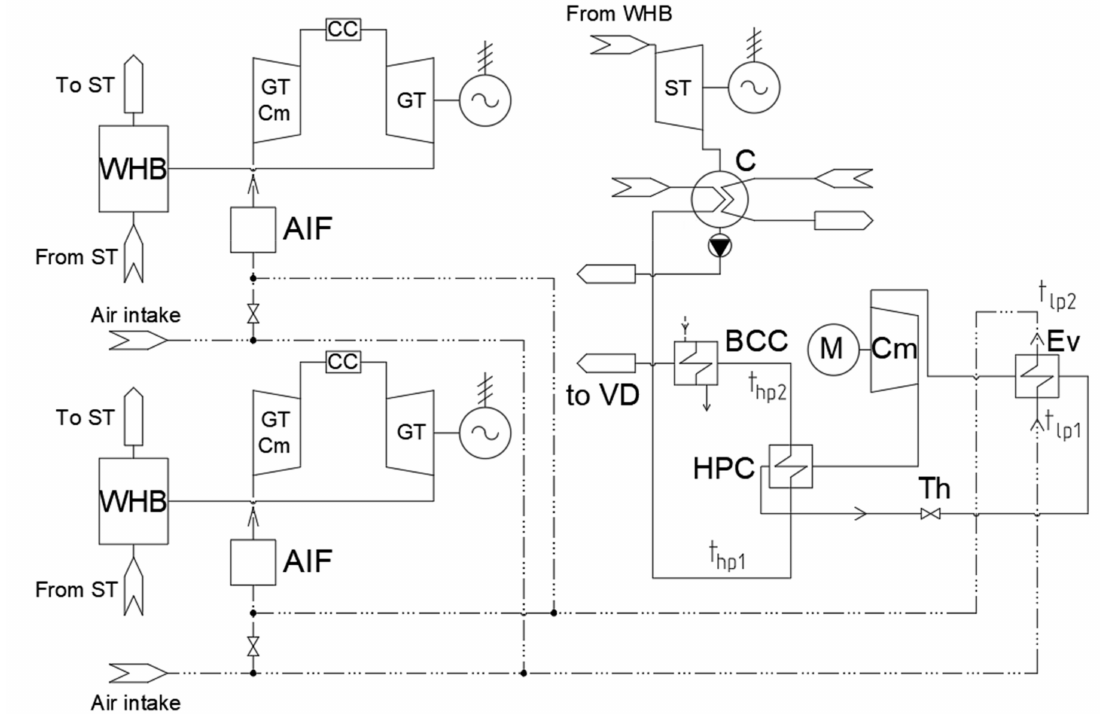
Figure 7. The scheme of air cooling and heating make-up water in summer time using a simple scheme VCHP. AIF—air intake filter; CC—combustion chamber; GT Cm—GT